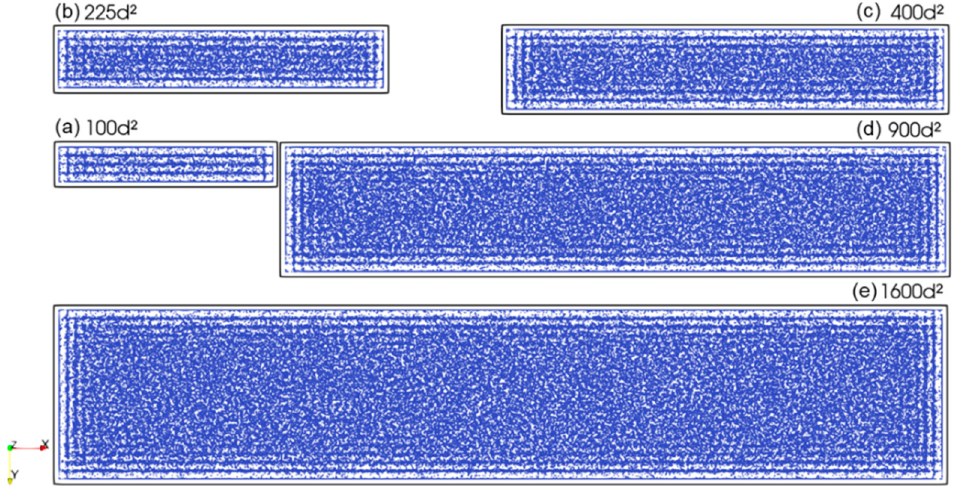
Figure 12. Pebble center distribution in the x–y plane of the rectangular pebble beds with a fixed aspect ratio of 5 and various cross-sectional areas of ( a ) 100 d 2 , ( b ) 225 d 2 , ( c ) 400 d 2 , ( d ) 900 d 2 , ( e ) 1600 d 2 .